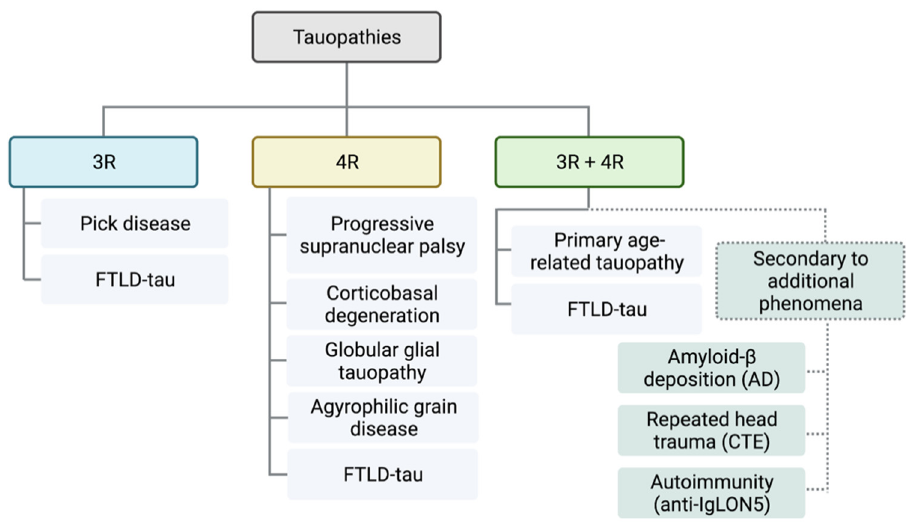
Figure 4. Molecular classification scheme of tauopathies. Tauopathies are divided into those with pathological tau aggregations of isoforms with 3 repeats (3R, blue) or 4 repeats (4R, yellow) of the microtubule binding domain, or a mixture of 3R and 4R isoforms (3R + 4R, green). Secondary tauopathies (broken lines) are associated with additional pathologies or etiologies such as amyloid- β protein deposition (i.e., Alzheimer’s disease (AD)), repeated head trauma (i.e., chronic traumatic encephalopathy (CTE)) or autoimmune disease (e.g., anti-IgLON5-related tauopathy). Primary tauopathies (unbroken lines) are those where tau deposition is the predominant pathology driving the neurodegeneration.